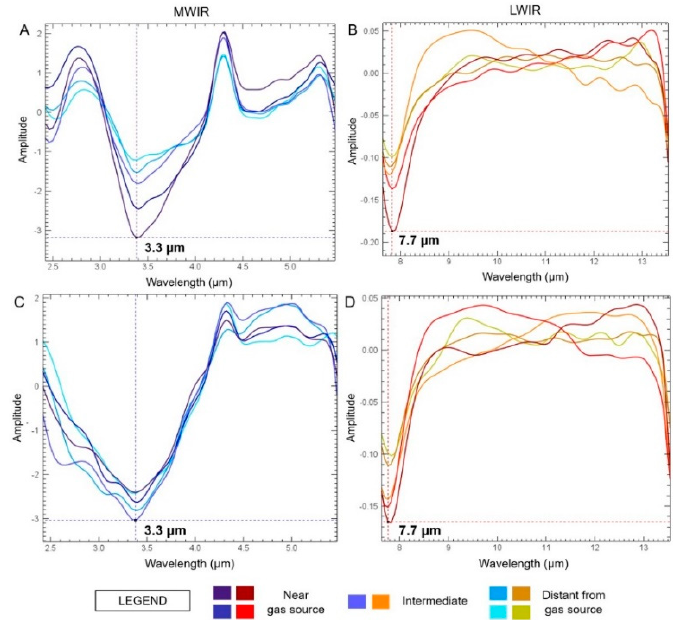
Figure 7. SEBASS MWIR ( A , C ) and LWIR ( B , D ) spectral signatures in the wavelet domain extracted from pixels near and far from emission sources. ( A , B ) Station 5 (subsurface leak of 29 m 3 /h; data acquisition at 457 m). ( C , D ) Station 33-MX-10 (surface leak of 41.1 m 3 /h; data acquisition at 762 m). Main absorption features are indicated in each plot.